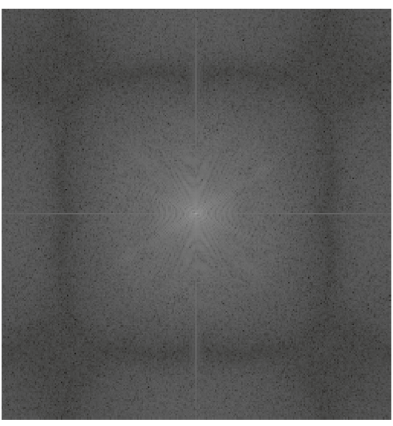
Figure 13: Grayscale PSD estimate. Table 1: Parametric comparison for filters.